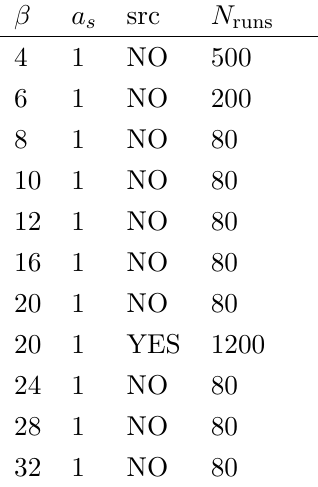
Table 1 . Parameters used in the simulations underlying our extraction of the proper static inter- action potential in classical lattice gauge